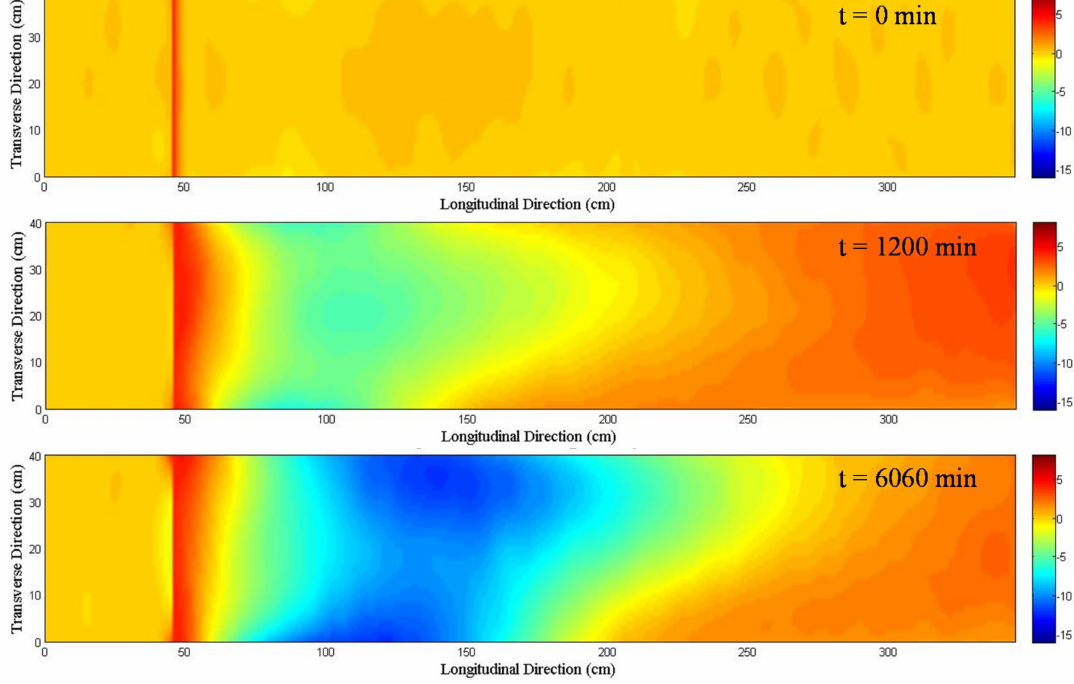
Figure 2. Temporal evolution of bed topography contours (Test CS2) in cm (flow from left to